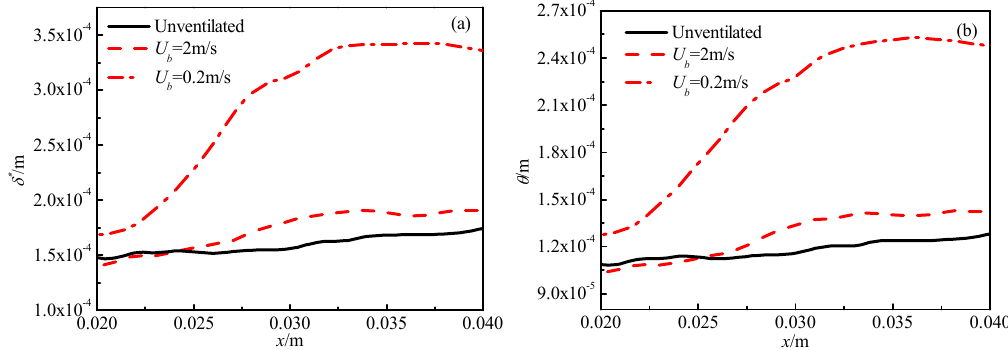
Figure 13. Streamwise variation in displacement thickness and momentum thickness of the boundary layer: ( a ) displacement thickness and ( b ) momentum thickness.